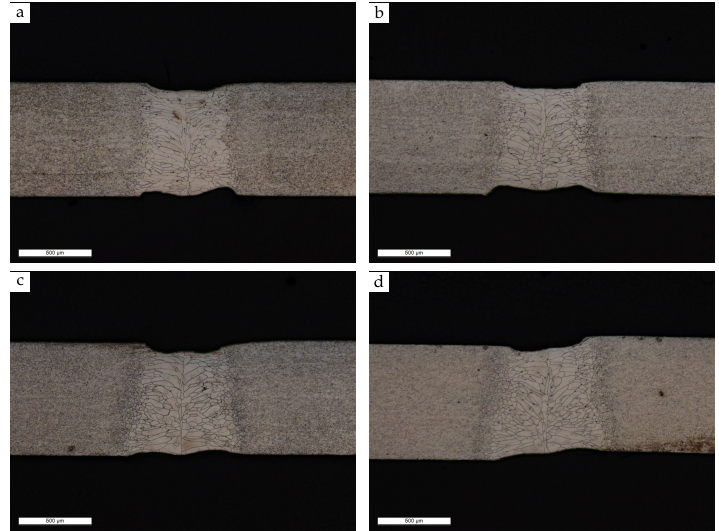
Figure 5. Etched macrographs of AISI430 weld seams obtained at energy inputs of ( a ) 18 J · mm − 1 , ( b ) 20 J · mm − 1 , ( c ) 22 J · mm − 1 and ( d ) 24 J · mm − 1